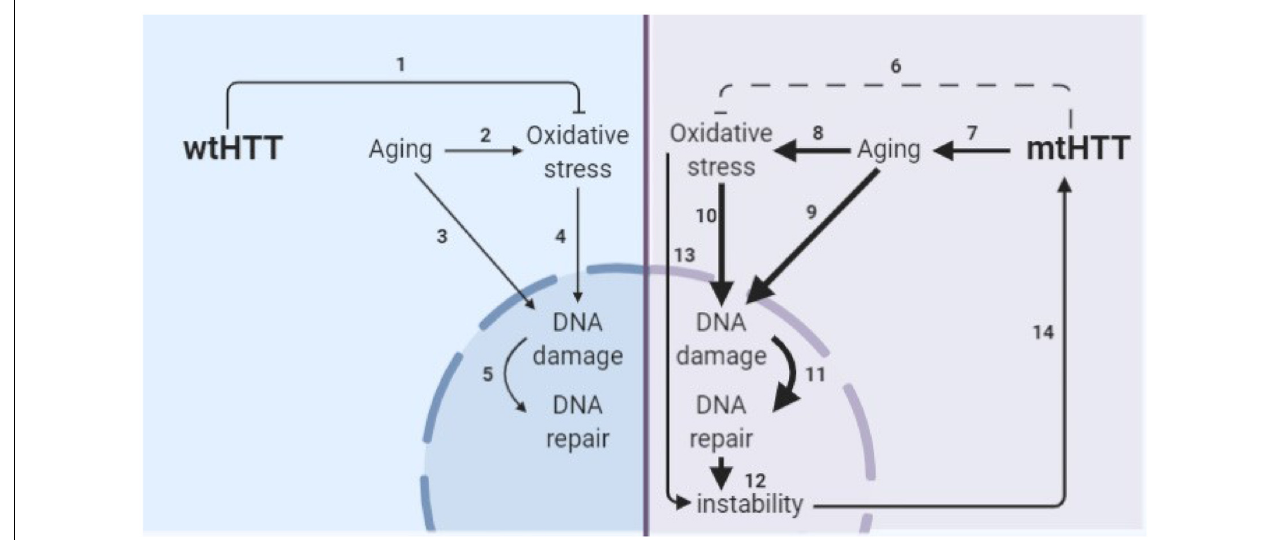
FIGURE 8 | Model of the interplay of aging and oxidative stress in HD pathogenesis. (1) wtHTT is a stress response protein that can form Huntingtin stress bodies in the cytoplasm (Nath et al., 2015), can act as a ROS and endoplasmic reticulum (ER) stress sensor (Atwal et al., 2007; DiGiovanni et al., 2016), and aid in the base excision repair pathway in the nucleus in response to DNA damage (Maiuri et al., 2017). (2) Aging increases oxidative stress in cells (Beckman and Ames, 1998; Andriollo-Sanchez et al., 2005). (3) Aging increases DNA damage (Maynard et al., 2015). (4) Oxidative stress increases oxidative damage (Barzilai and Yamamoto, 2004). (5) DNA damage increases DNA repair particularly the base-excision repair pathway (Maynard et al., 2015; Prasad et al., 2015; Cadet et al., 2017). (6) mtHTT does not perform its stress response functions in the cell as well (Nath et al., 2015; Maiuri et al., 2017). Additionally, (7–11) accelerated epigenetic aging has been found in age-matched HD brains (Horvath et al., 2016) and age-related nuclear pore complex deficiencies have been found in HD (Grima et al., 2017), which collectively drive greater age-related oxidative stress and DNA damage and greater subsequent base excision DNA repair. (12) Altering the rate of base-excision repair can increase somatic instability of the CAG tract (Kovtun et al., 2007; Goula et al., 2009; Budworth et al., 2015). (13) Oxidative stress can cause somatic instability of the CAG tract (Jonson et al., 2013), possibly through the DNA damage/DNA repair pathway. (14) Somatic instability of the CAG tract is a driver of mtHTT toxicity and may be necessary for certain tissues for onset and progression of HD (Swami et al., 2009; Budworth et al., 2015; Flower et al.,